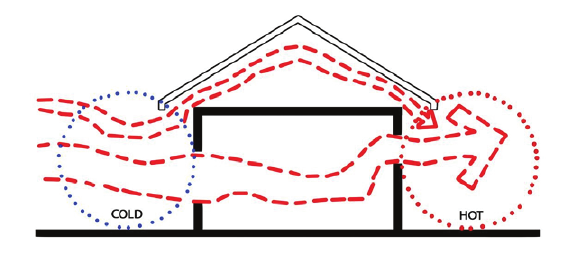
Figure 3. Air circulation